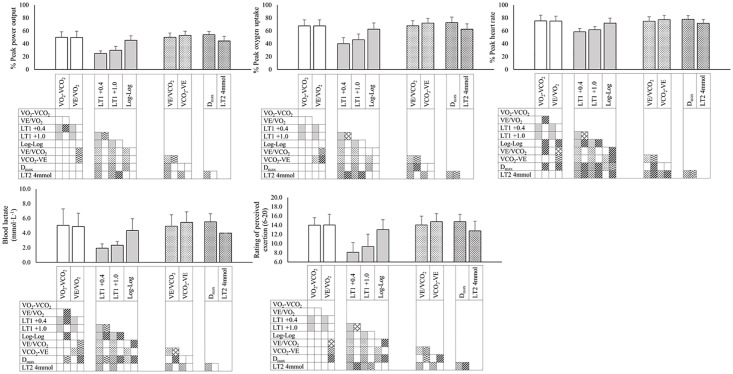
Outcome parameters at the VT, LT1, RCT and LT2.Outcome parameters at the aerobic threshold are determined by the V-slope (VO2-VCO2 data) and the ventilatory equivalent method (VE/VO2 data) to identify the VT, and a fixed rise in BLa of 0.4 and 1.0 mmol·L-1 and the log-log transformed VO2-BLa data to identify the LT1. Outcome parameters at the anaerobic threshold are determined by the ventilatory equivalent method (VE/VCO2 data) and the respiratory compensation point (VCO2-VE data) to identify the RCT, and the modified Dmax method and a fixed BLa value of 4 mmol·L-1 to identify the LT2. The data used is from 15 elite Para ice hockey players following a protocol with stepwise increases in workload every 5 min while upper-body poling. The data presented is the mean of all 15 participants and error bars denote +1 SD. Filled squares in the left columns denote significant differences between methods at an alpha level of 0.05. Filled squares in the right columns denote significant correlations of methods (upward diagonal = moderate, zig zag = high, diamond outline = very high) at an alpha level of 0.05.